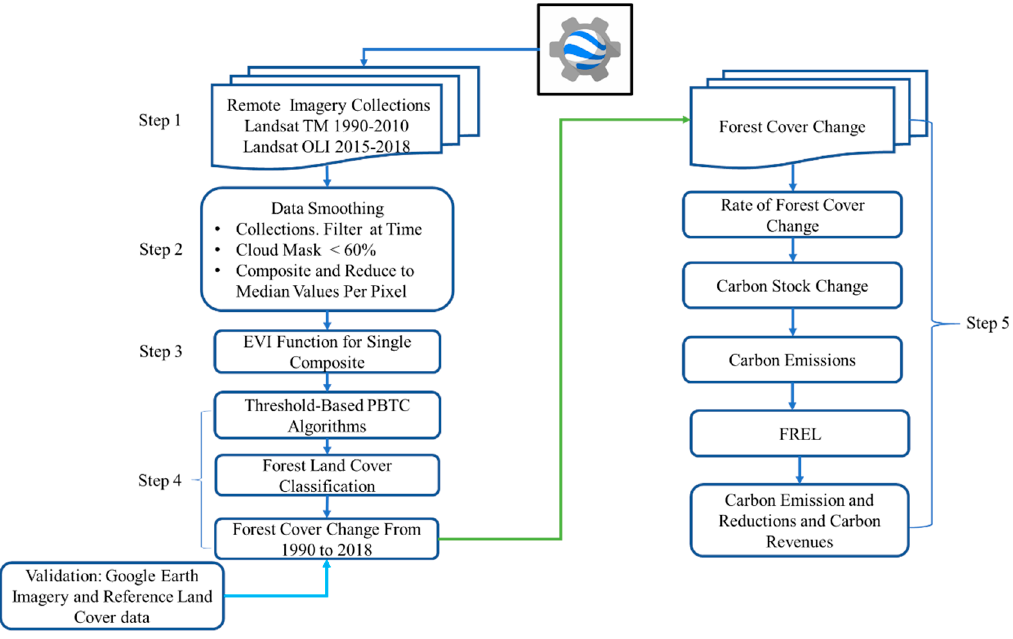
Figure 2. PBTC methodology in Google Earth Engine for land cover mapping in Siem Reap province, Cambodia.